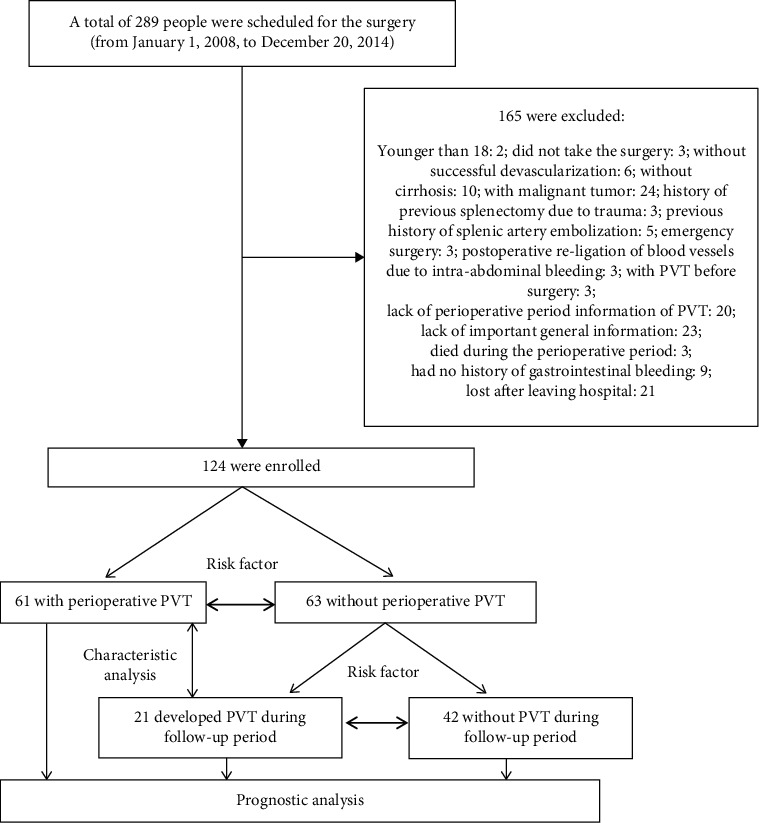
Research flowchart.